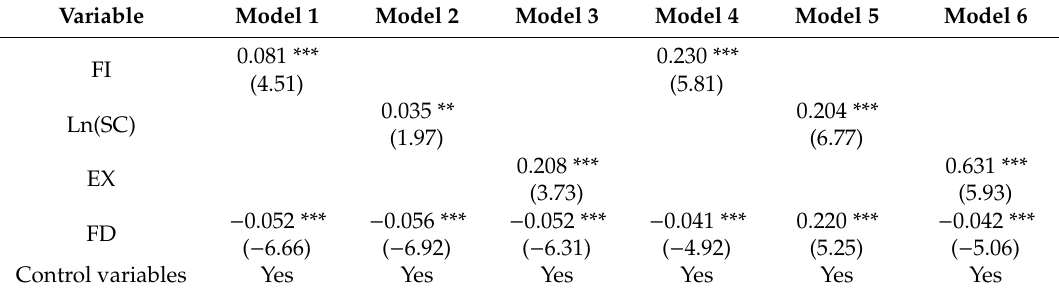
Table 7. The results of spatial generalized moment estimation